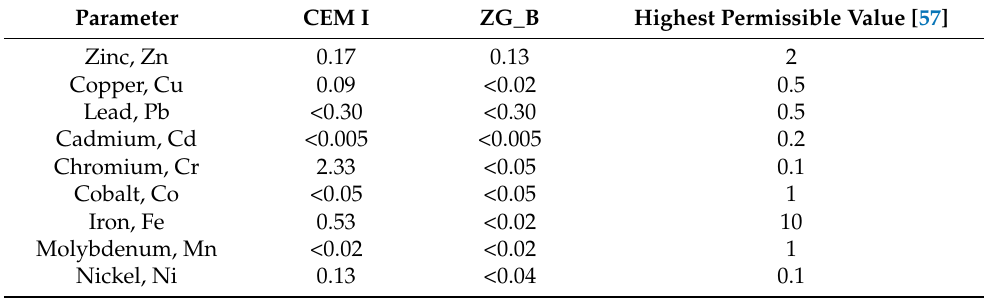
Table 10. Heavy metal content (mg/L) in water extracts for monolithic rock wool geopolymers.